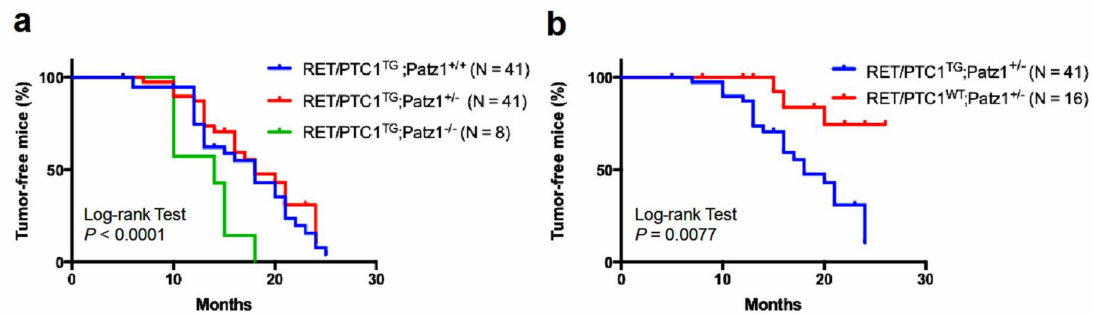
Figure 1. Tumor incidence curves. ( a ) Kaplan–Meier analysis of the effect of progressive Patz1 deletion on the thyroid tumor incidence of RET/PTC1 mice. The comparison of the survival curves by log-rank test showed they were significantly different ( p < 0.0001), with the worst outcome in RET/PTC1 mice carrying the homozygous deletion of the Patz1 gene. Comparison of single curves by log-rank (Mantel–Cox) test revealed significant differences between RET/PTC1 TG ;Patz1 − / − and either RET/PTC1 TG ;Patz1 +/+ or RET/PTC1 TG ;Patz1 +/ − mice ( p = 0.029 and 0.0032, respectively), whereas no significant differences resulted between RET/PTC1 TG ;Patz1 +/ − and RET/PTC1 TG ;Patz1 +/+ mice ( p = 0.36); ( b ) Kaplan–Meier analysis of Patz1 +/ − mice with or without RET/PTC1 transgene were compared by log-rank test: they were significantly different ( p =